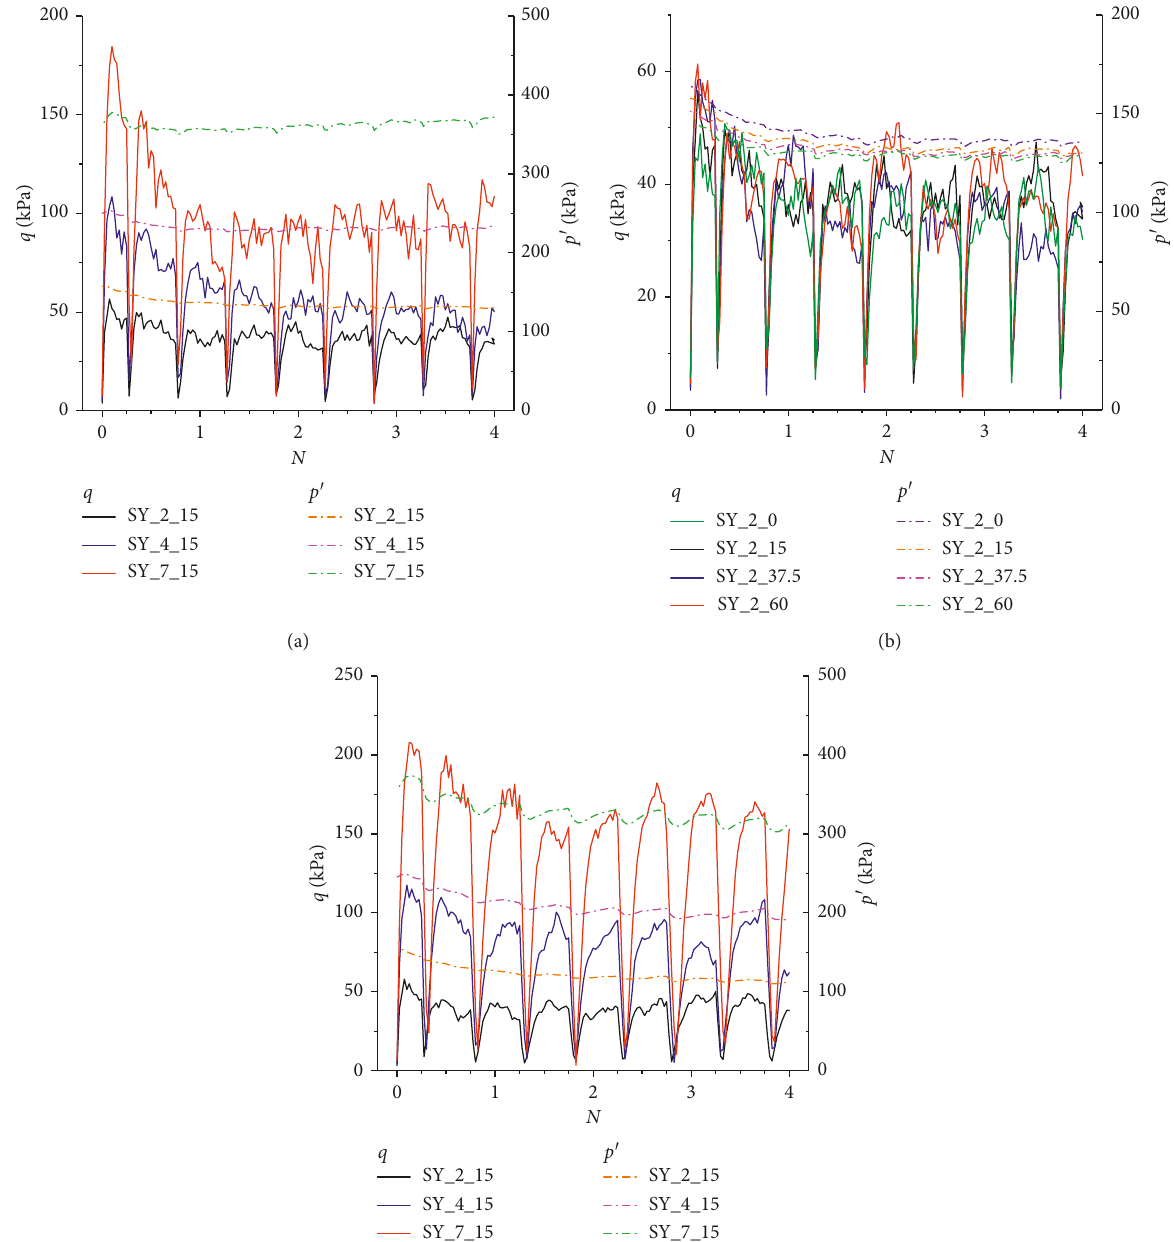
Figure 20: Evolution of q and p ′ : (a) reference group; (b) composite pattern group; (c) unbreakable